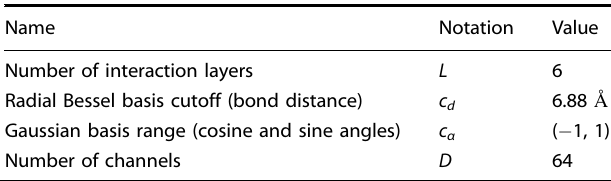
Table 1. Model parameters.